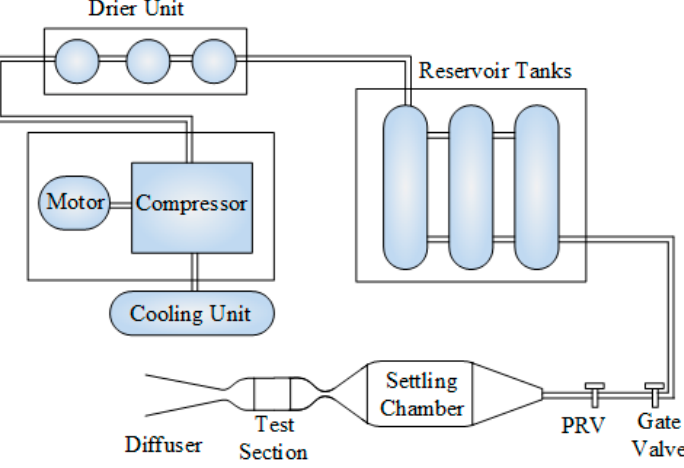
Figure 2. The supersonic wind tunnel facility (schematic diagram with notations).